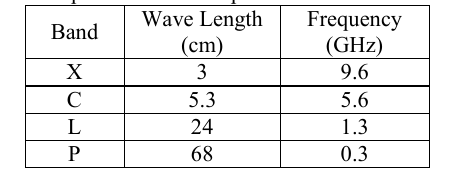
Table 1. Typical wavelength and frequency for SAR bands (Dowman, 2004) Digital elevation models (DEMs) can be generated by interferometric SAR (InSAR) and radargrammetry techniques from different positions of Synthetic Aperture Radar (SAR) images. (Yu et al, 2010)